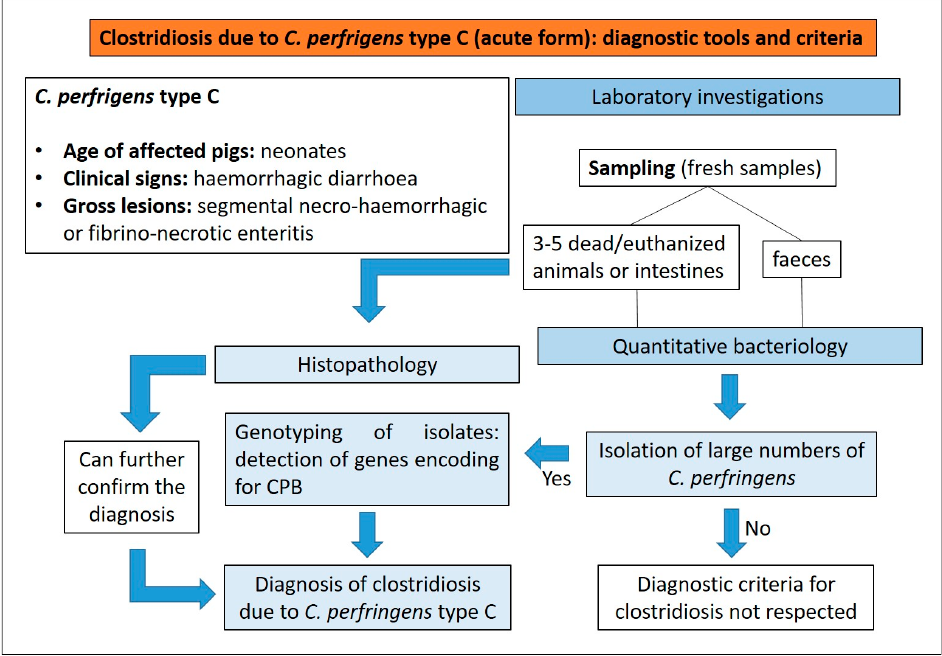
Figure 11 Figure 11. Diagnostic algorithm for the diagnosis of clostridiosis due to C. perfrigens type C in